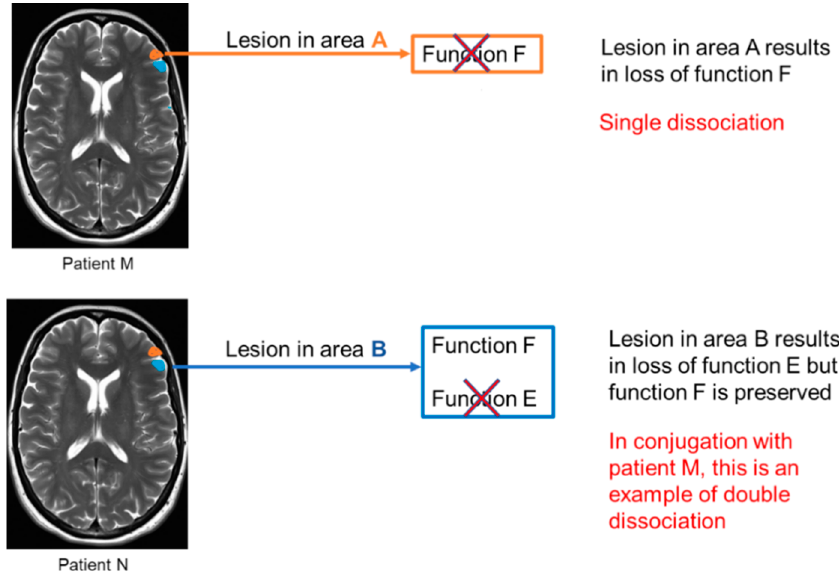
Figure 2. Schematic representation of single and double dissociation. In this example a lesion in area A (marked with orange in the MR image) leads to a loss of function F; however, function E is preserved. This represents single dissociation. In patient N, there is a lesion in area B (marked with blue in MR image), which leads to loss of function E however function F is preserved. This in conjugation with patient M who has a loss of function F but preserved function E, represents an example of double dissociation.